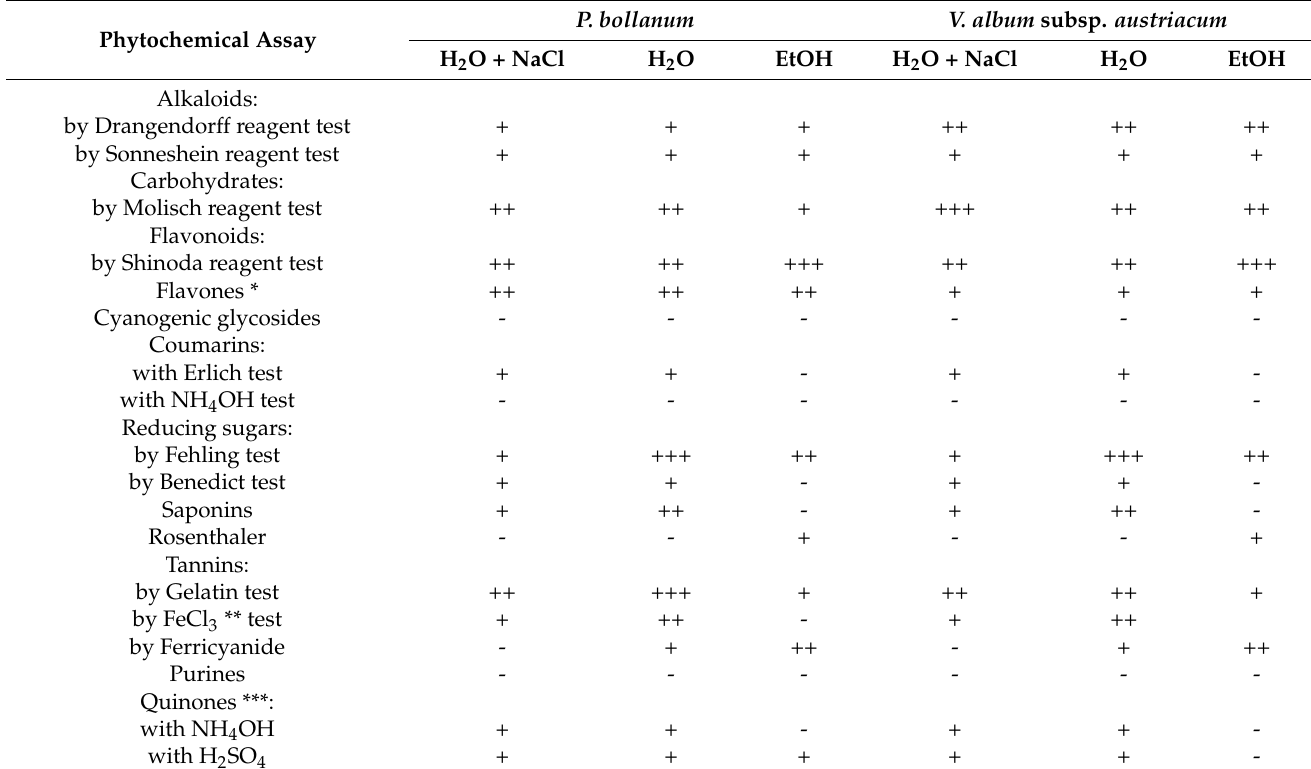
Table 2. Estimation of phytochemical compound groups of P. bollanum and V. album subsp. austriacum . Phytochemical Assay